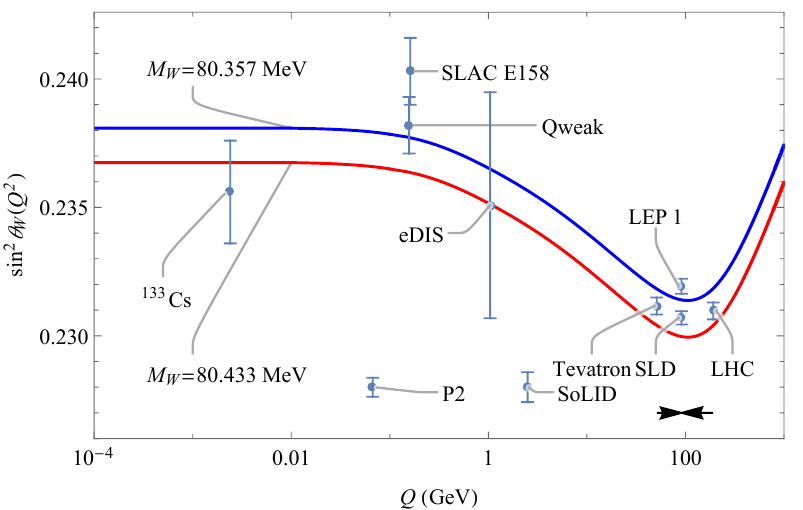
Figure 2. (Color online) Running of sin ˆ θ W predicted by the Standard Model (SM) with the mass of the W boson being M W = 80.357GeV/c 2 [82] (blue line) and the SM with the new value M W = 80.433GeV/c 2 [33] (red line). Results of several low-energy parity-violating lepton scat- tering experiments, as well as Z -pole measurements are also presented. The points P2 and SoLID are projected values from MESA’s P2 experiment [116] and Jefferson Lab’s SoLID experiment [117]. For clarity, the Tevatron and LHC results have been horizontally